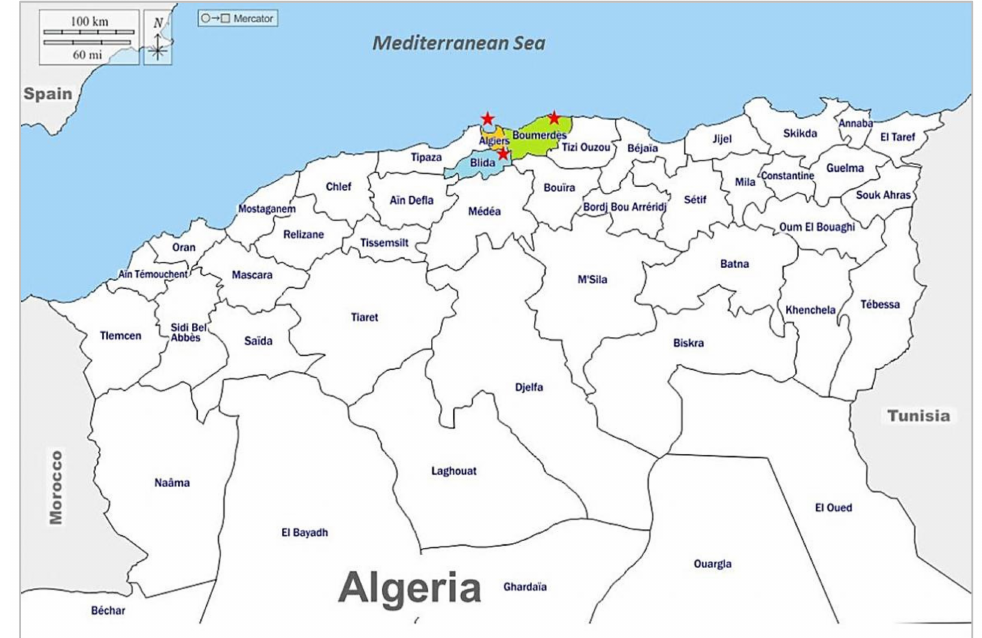
Figure 1. Geographic localization of the three investigated dairy